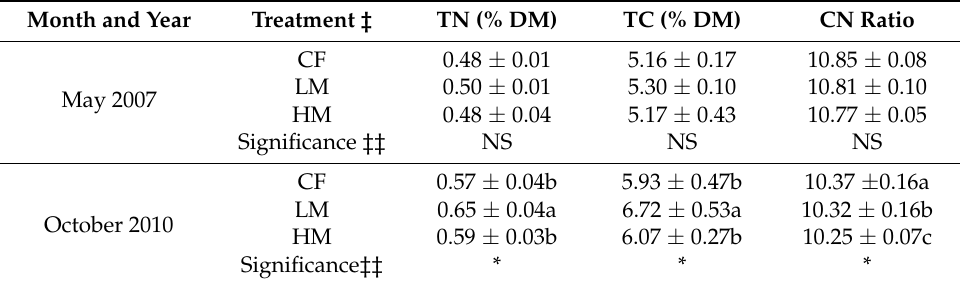
Table 1. Total nitrogen (TN) and total carbon (TC) content, and carbon-to-nitrogen ratio (CN) in soils at the start and end of trials (May 2007 and October 2010, respectively), as affected by fertilizer